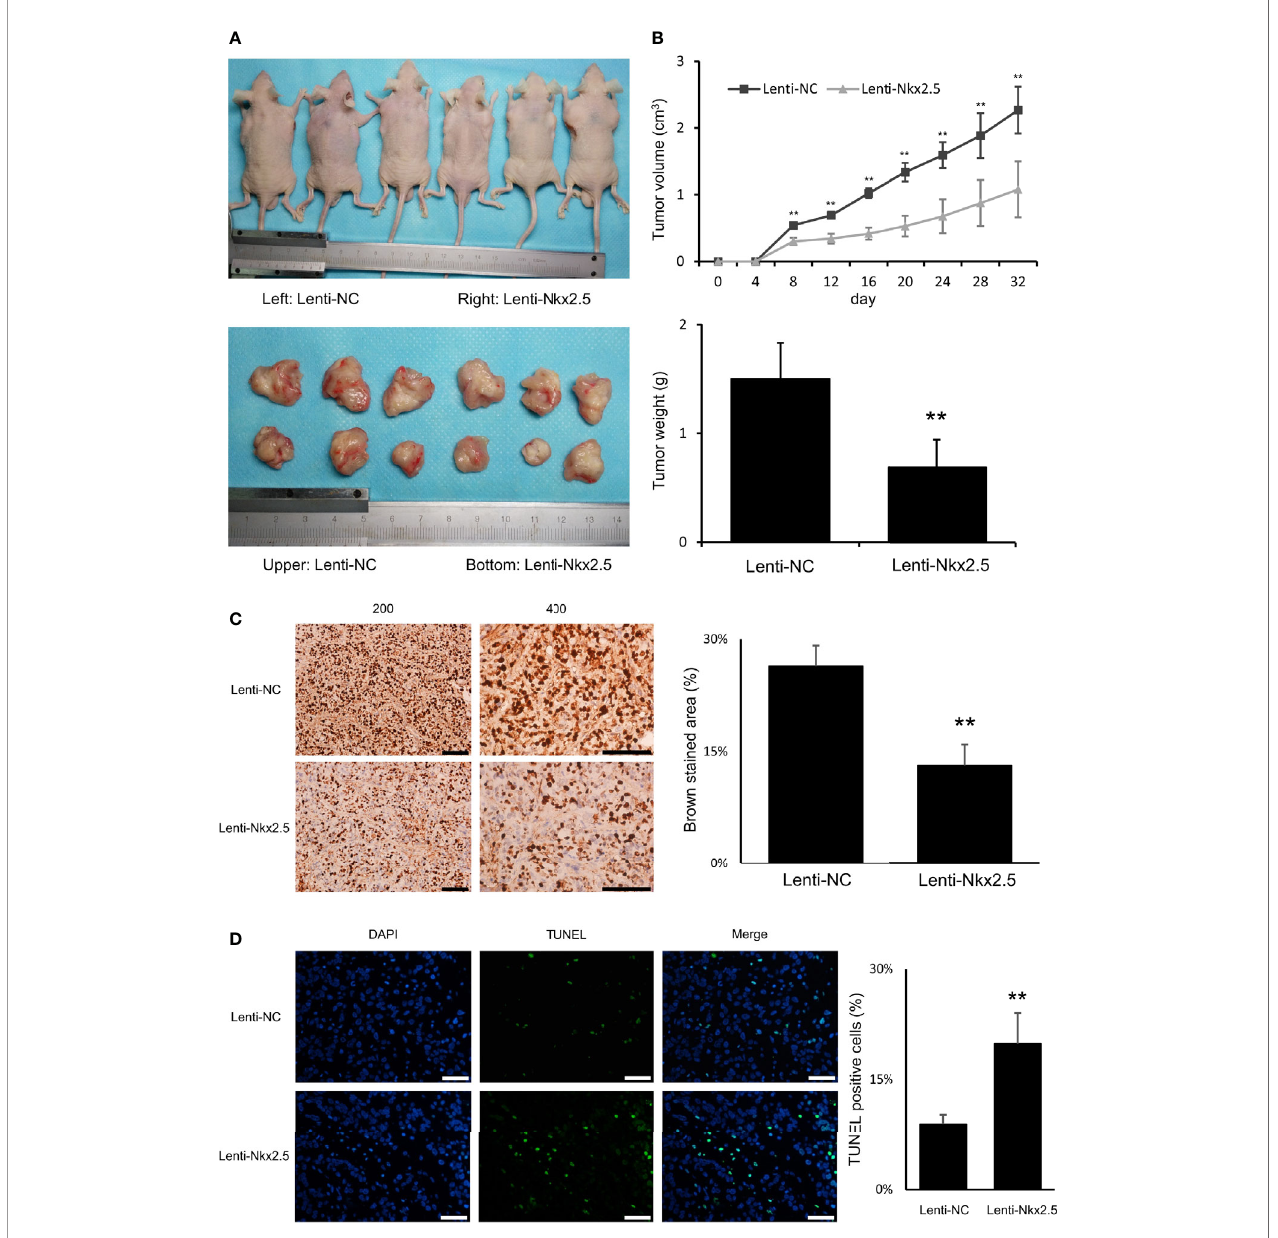
FIGURE 4 | Nkx2.5 could suppress tumor formation, growth, proliferation, and increase apoptosis of HCT116 cells in vivo . (A) Photographs of tumors in mice that were excised 32 days after inoculation of Lenti-NC and Lenti-Nkx2.5 HCT116 cells into athymic nude mice. (B) Growth of tumor volume was plotted over time, and weight of tumor at the end of 32 days was illustrated (6 mice/group). (C) Immunohistochemical staining of Lenti-NC and Lenti-Nkx2.5 cells using Ki-67. Representative photographs were taken at magni fi cations of 200× and 400×. Scale bar (black) is 100- m m. (D) Representative pro fi les for TUNEL assay of the Lenti- NC and Lenti-Nkx2.5 cells. Green fl uorescence indicates TUNEL-positive cells in the microscopic fi eld. DAPI was used for nuclear staining. Representative photographs were taken at magni fi cation of 400×. Scale bar (white) is 50- m m. ** represents P <